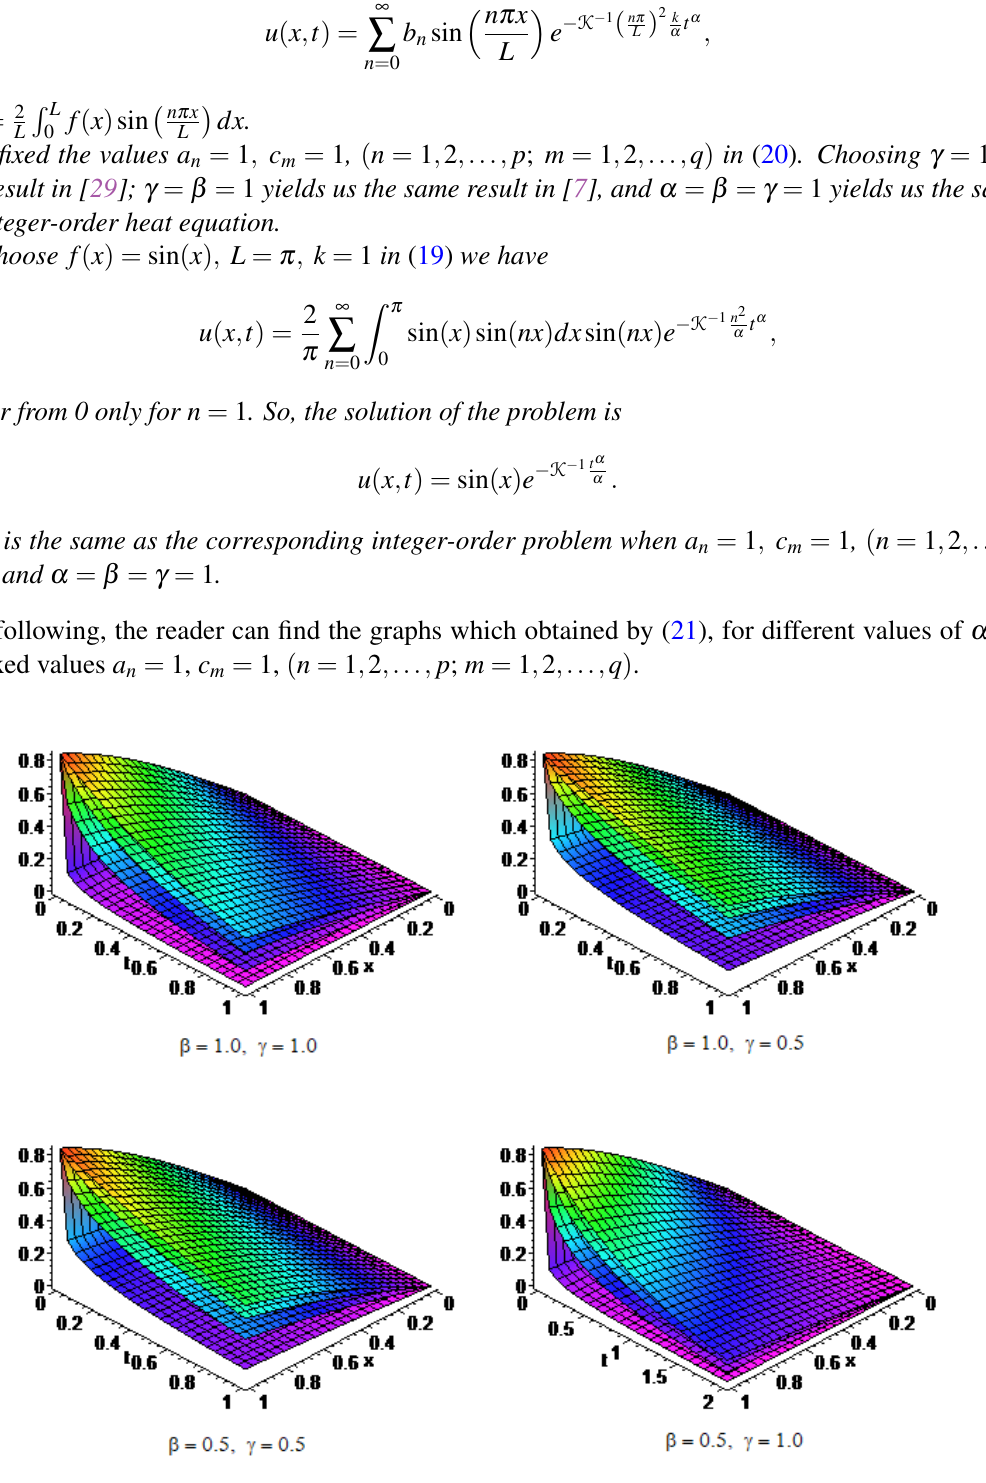
Fig. 2 The graphs of (21) from α = 0 . 25 (bottom) to α = 1 . 00 (top) by step size 0 .